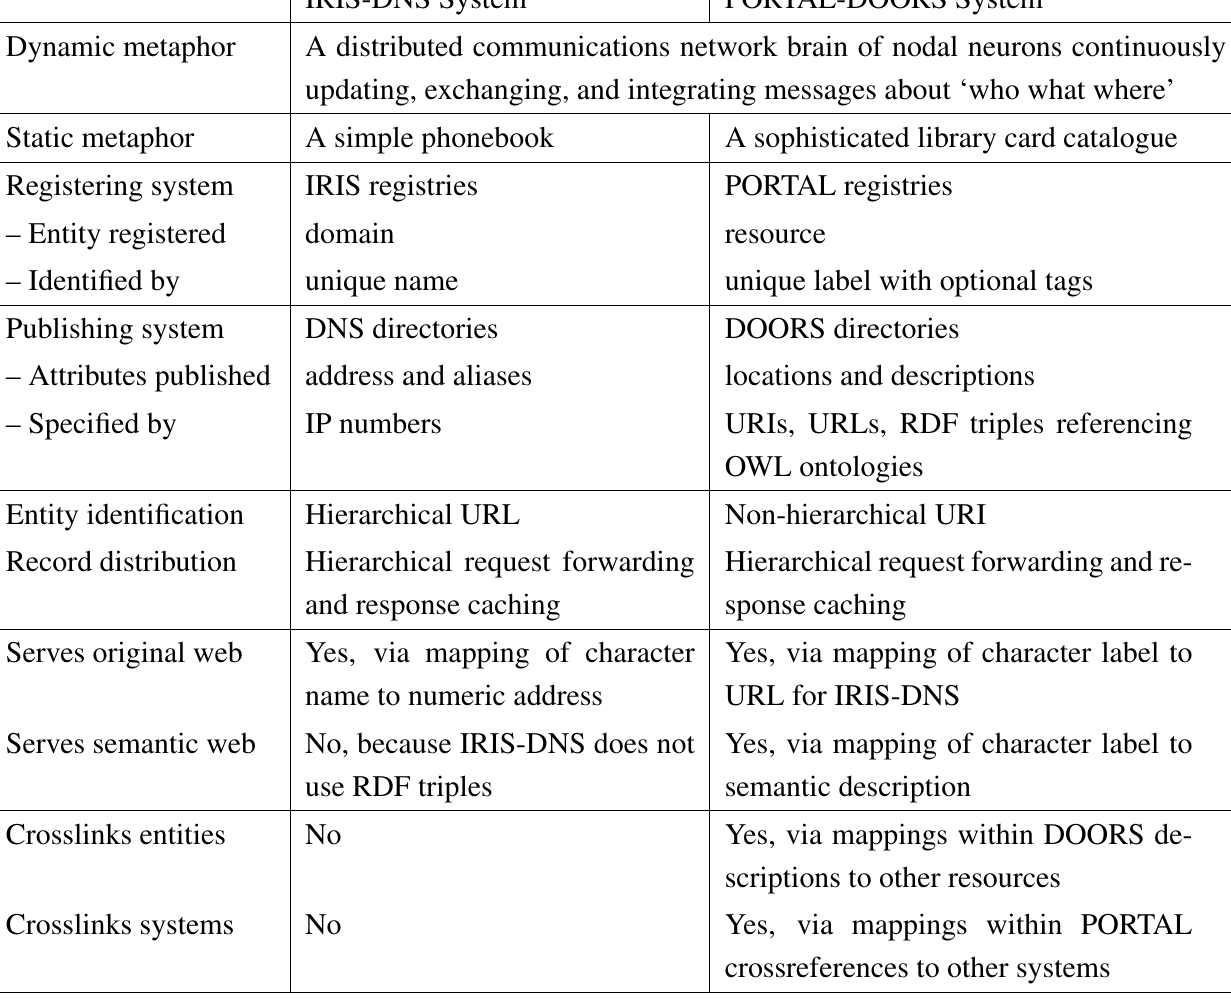
Table 1. Hierarchically Distributed Mobile Metadata (HDMM) Systems with Entity Regis- tering and Attribute